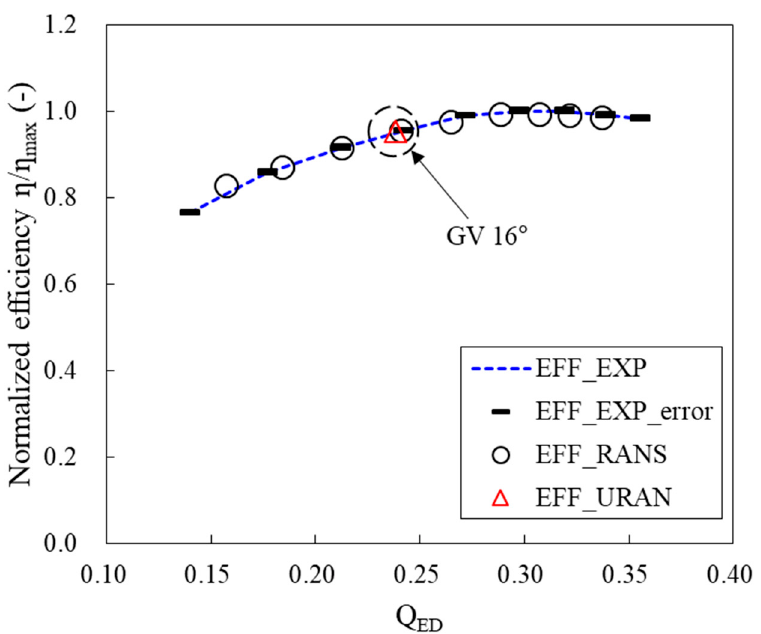
Figure 4. Comparison of the numerical and the experimental results obtained for the Francis tur- bine model.